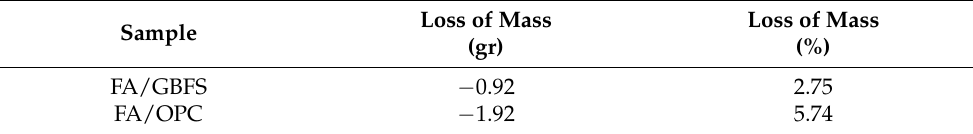
Table 4. Percentage loss of mass of the steels embedded in the concretes after the accelerated.